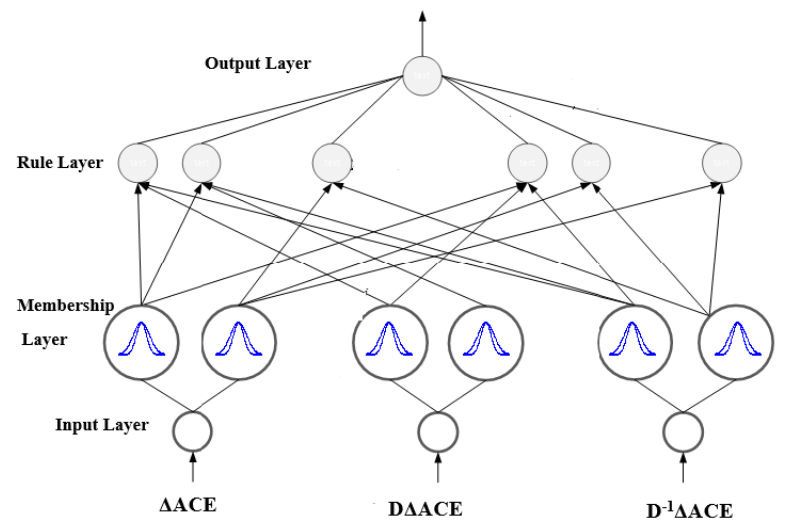
Figure 3. Type-2 fuzzy